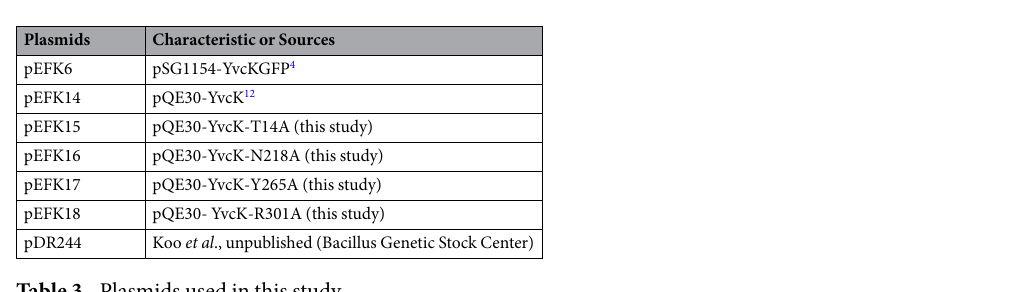
Table 3. Plasmids used in this